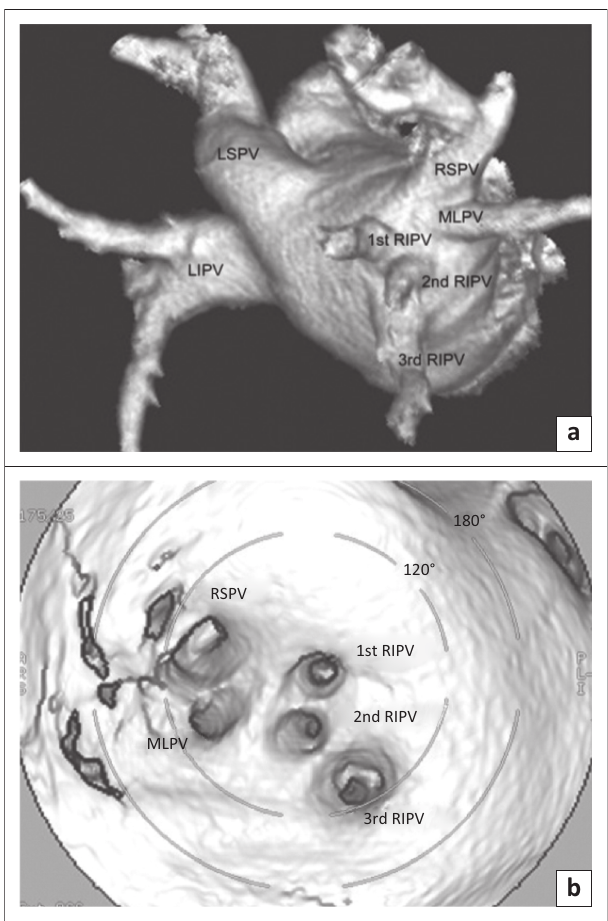
LSPV, left superior pulmonary vein; LIPV, left inferior pulmonary vein; RSPV, right superior pulmonary vein; MLPV, middle lobe pulmonary vein; 1st RIPV, first right inferior pulmonary vein; 2nd RIPV, second right inferior pulmonary vein; 3rd RIPV, third right inferior pulmonary vein. FIGURE 7: Combination of supernumerary veins in a 48-year-old man prior to a radiofrequency ablation procedure for atrial fibrillation: (a) Three-dimensional model. There is direct drainage of the middle lobe into the left atrium and three right inferior pulmonary veins. Left superior pulmonary vein (LSPV), left inferior pulmonary vein (LIPV), right superior pulmonary vein (RSPV), middle lobe pulmonary vein (MLPV), first right inferior pulmonary vein (1st RIPV), second right inferior pulmonary vein (2nd RIPV) and third right inferior pulmonary vein (3rd RIPV). (b) Endocardial view. Right superior pulmonary vein (RSPV), middle lobe pulmonary vein (MLPV), first right inferior pulmonary vein (1st RIPV), second right inferior pulmonary vein (2nd RIPV) and third right inferior pulmonary vein (3rd